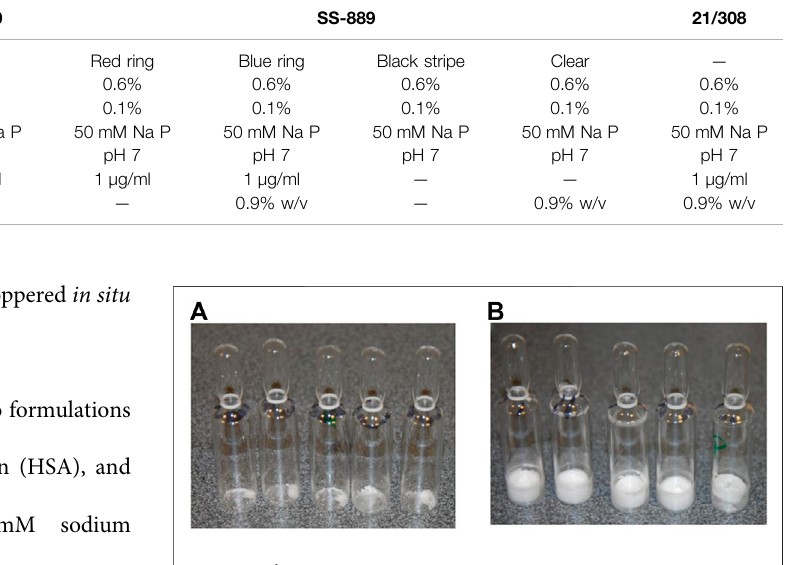
FIGURE 1 | FD trial SS-879 options (A) acetate and (B) phosphate- physical